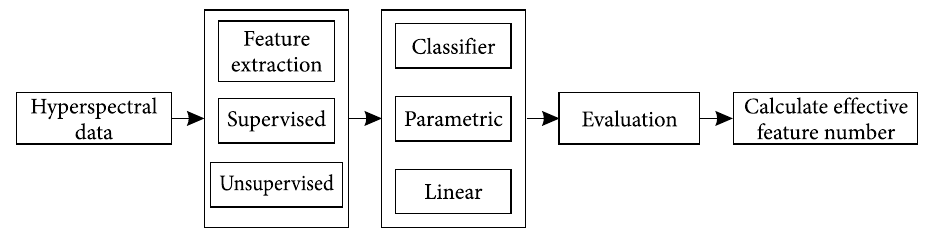
Fig. 2. Workflow of pixel-based classification framework